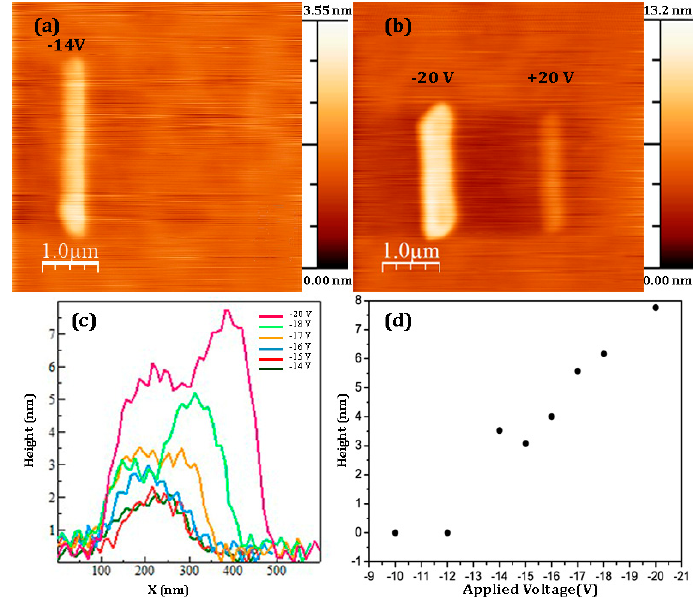
Figure 2. Topography of BaTiO 3 thin film after application of ±14 V ( a ) and ±20 V; ( b ) during scanning of the area 0.2 × 2 μ m 2 ; ( c ) Comparison of the topography cross-sections of the areas poled with different voltages; ( d ) Average height of the poled areas vs. applied negative voltage.